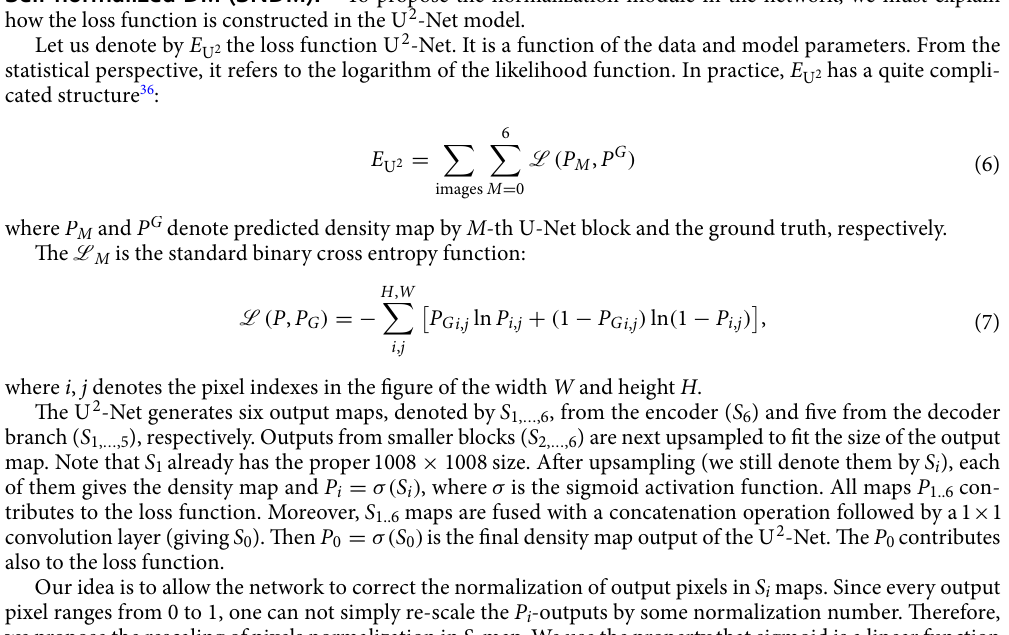
(objects) correctly but has a problem finding the correct normalization for the images with a larger number of colonies. Therefore, we propose a modification of the network architecture so that the network can correct by itself the normalization of the output.